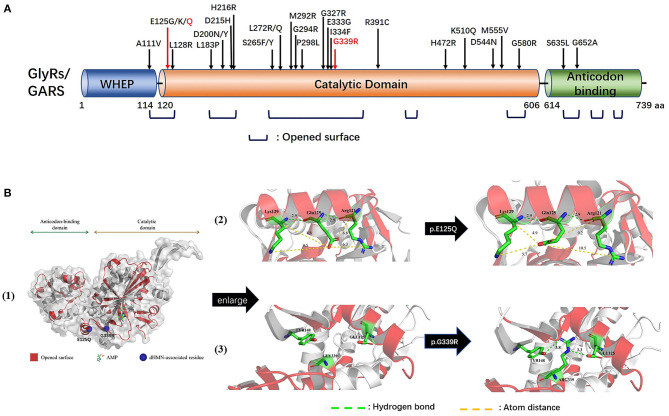
Schematic representation of GARS gene/protein and location of mutations. (A) Distribution CMT2D/dHMN-associated mutations in the three domains of the cytosolic human glycyl-tRNA synthetase (GlyRS). Red: Novel mutations identified with dHMN-V in this study. Most reported GARS mutations are located in the catalytic domain or lie in one of the eight opened surface regions. Amino acid nomenclature based on transcript NM 002047.2(739 a.a). (B) Molecular structures of integral type (left), wild type (middle), and mutant type (right) of human GlyRS (PDB ID: 4KR2). Both residues, p.E125 and p.G339, are strictly conserved in opened-up surface area of hGlyRS, among which p.G339 also located within the glycine-binding pocket. The substitution of p.E125Q altered the charge and space resistance with adjacent amino acids. The substitution of p.G339R engendered neomorphic hydrogen bonding interactions between residue p.G339 and p.Y148/p.E125.